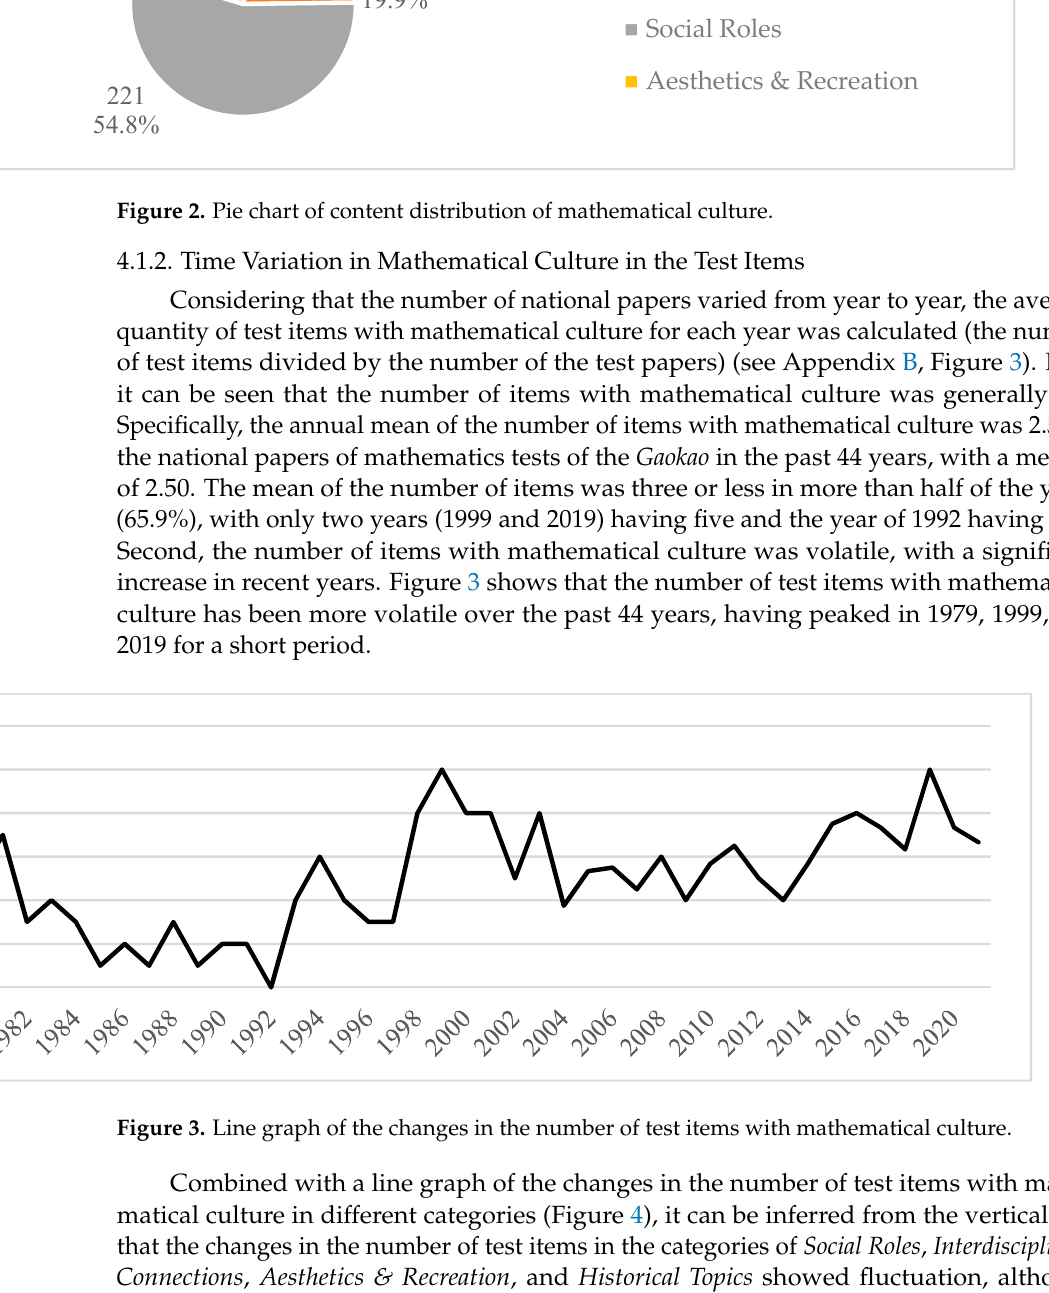
Figure 4. Line graph of the changes in the number of test items with mathematical culture in differ- ent categories. 4.2. The Specific Features of Different Categories 4.2.1. Historical Topics The number of items with mathematical culture in each sub-category of the Historical Topics category in the national papers of mathematics tests of the Gaokao in the past 44 years were counted. Table 3 shows that the category of Historical Topics had the following characteristics in terms of content distribution: First, items in this category were relatively small in number but more diverse in their content settings. Second, the content distribu- tion was uneven. More than 80% of the items in this category were related to historical problems, formulas, and theorems in history, such as mutual subtraction and the Qin Jiushao algorithm (the Horner algorithm) in the Nine Chapters on the Mathematical Art . Third, each sub-category was very similar in the selected materials, with materials mainly from the proofs of several famous formulas and theorems (including the Gougu Theorem (the Pythagorean Theorem), the Law of Sines, the Law of Cosines, and the Formula for the